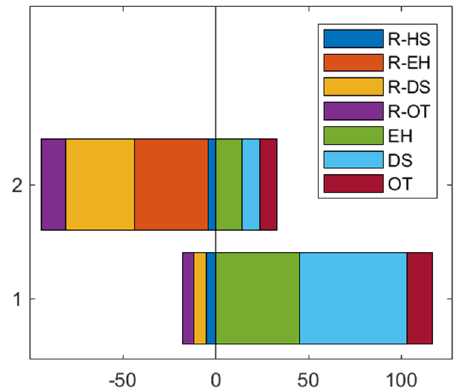
Figure 13. Distribution of selective planting characteristics.